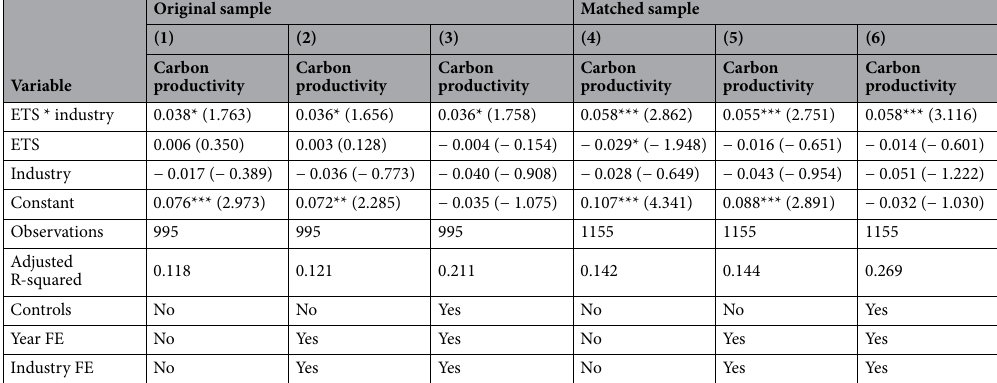
Table 2. Estimated effects of ETS participation on carbon productivity as determined by regression analyses. Columns 1–3 provide results for non-matched firms, and columns 4–6 provide estimation results for firms paired by propensity score matching (PSM). Columns 1 and 4 report results without control variables and fixed effects (FE), columns 2 and 5 report results with year- and industry-fixed effects, and columns 3 and 6 includes